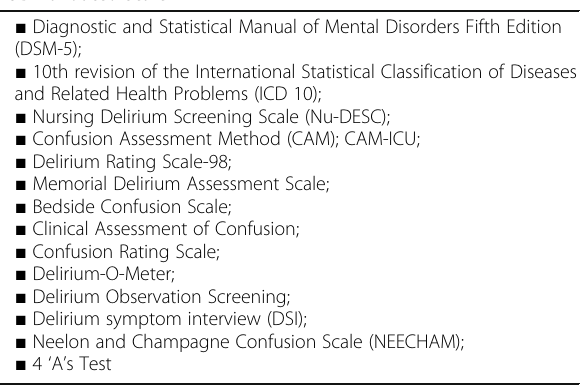
Table 1 Scales validated for POD monitoring listed in the European Society of Anesthesia and Intensive Care